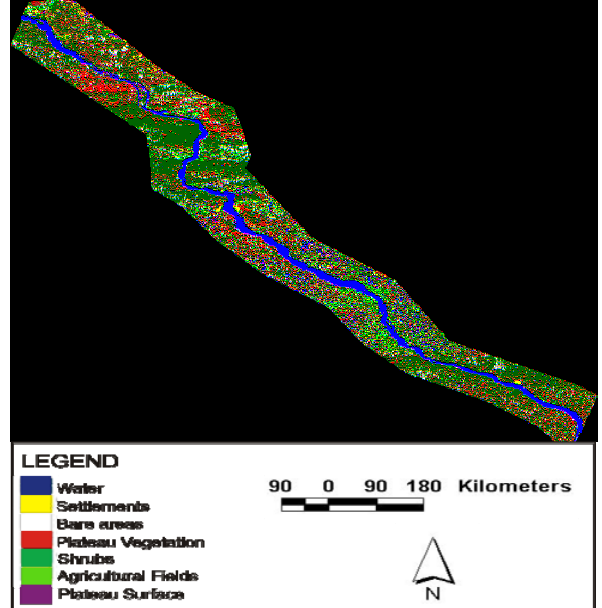
Figure 2.1: Classified Image of Landsat TM, 13 October